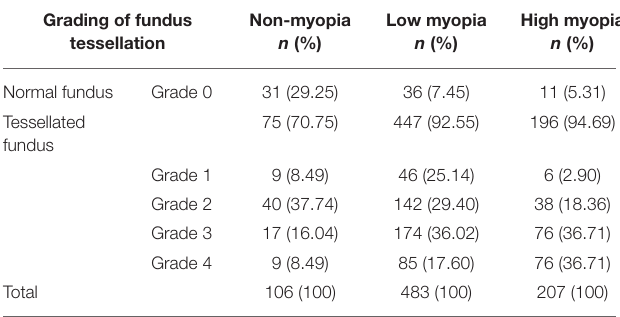
( Table 4 ). The data of each parameter were further divided and analyzed using interquartile range. Our results showed that